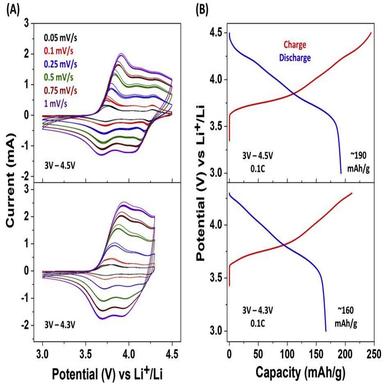
Assessment of electrochemical behavior of the NFA cathode material: (A) Cyclic voltammetry (B) Galvanostatic charge/discharge.